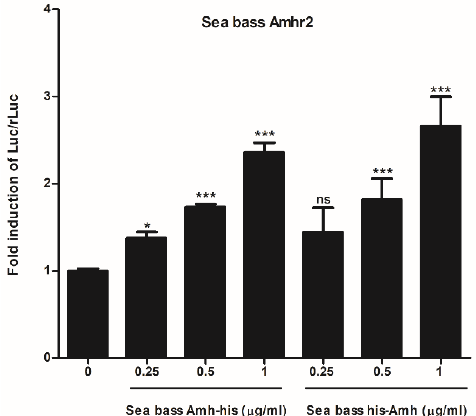
Figure 2. Recombinant sea bass AmhHis 6 and His 6 Amh induce sea bass type 2 Amh receptor (Amhr2)-dependent BRE-luc reporter activity. African green monkey kidney fibroblast-like (COS-7) cells were transiently transfected with sea bass Amhr2, along with the Bre-Luc reporter and pRL-TK plasmids. The cells were incubated with three different concentrations of purified recombinant sea bass AmhHis 6 or His 6 Amh for 24 h in a 1% FBS culture medium. Firefly luciferase activities were normalized to pRL-TK Renilla luciferase. The results shown are the fold induction of normalized luciferase activity, expressed as relative light units (RLUs), of each treatment over the values of cells treated with culture media obtained from P. pastoris expressing the empty pPIC9K vector. Data represent the mean ± SEM of three independent experiments (in triplicate for each condition) and were analyzed by ANOVA followed by Tukey’s significant interaction test. Bars with asterisks are significantly different (* p < 0.05; *** p < 0.001) and ns indicates there were no significant differences.